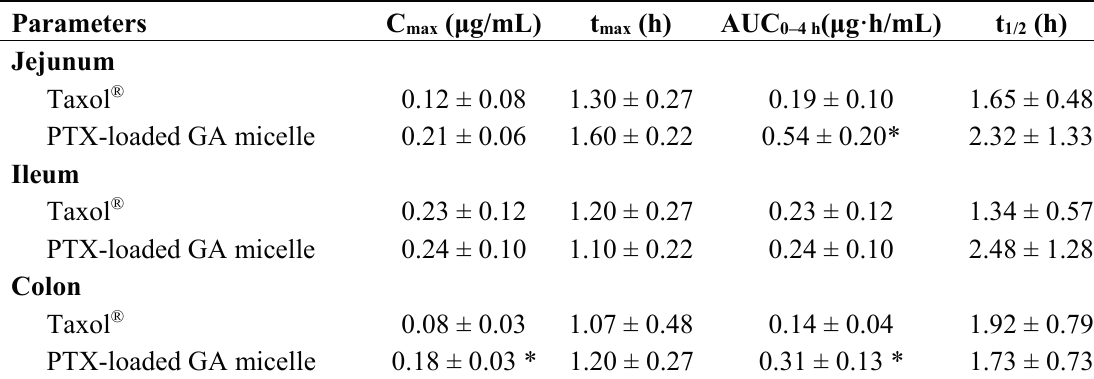
Figure 7. Mean plasma concentration-time profiles of paclitaxel following its administration into the jejunal loops ( A ), the ileal loops ( B ) and the colonic loops ( C ) of rats at a dose of 5 mg/kg of Taxol ® and PTX-GA micelles. Each data presented the mean ± S.D. of 5 rats. Table 4. Pharmacokinetic parameters of PTX after intestinal administration of Taxol ® (Cremophor ® EL-based formulation) and PTX-loaded GA micelles in different intestine regions determined by an in situ closed loop method ( n =